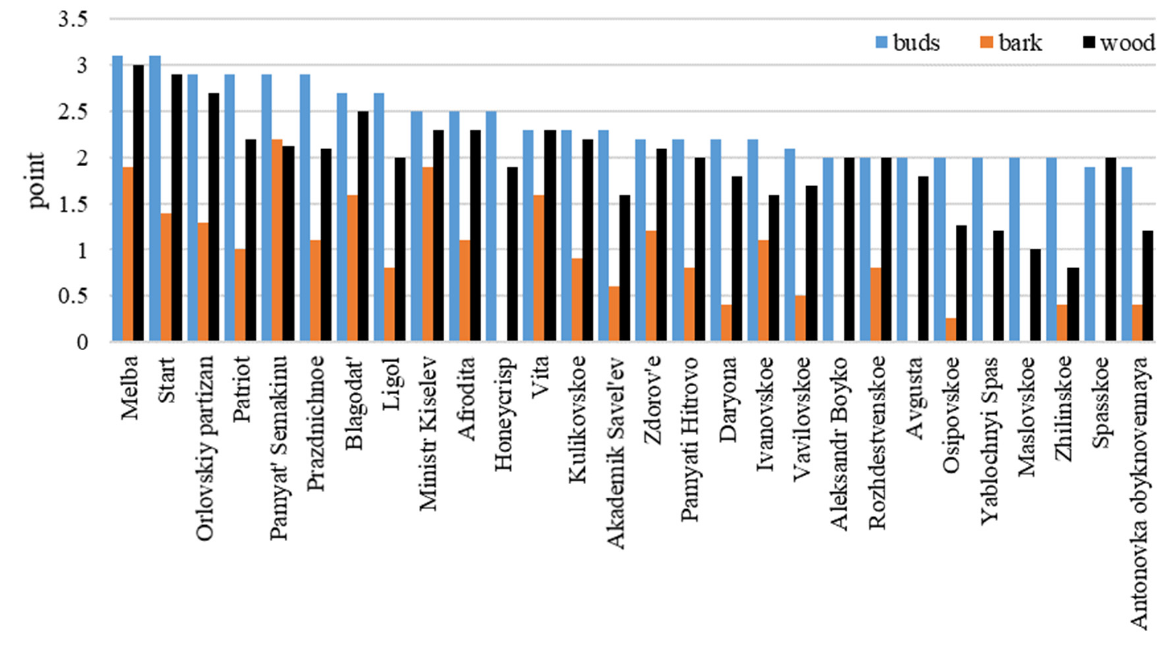
Figure 1. The degree of damage to the buds and tissues of shoots when modeling the frost at − 40 °C (Component II. − 5 °C, − 10 °C, − 40 °C) LSD05—0.3 (to buds); 0.4 (to bark and wood).